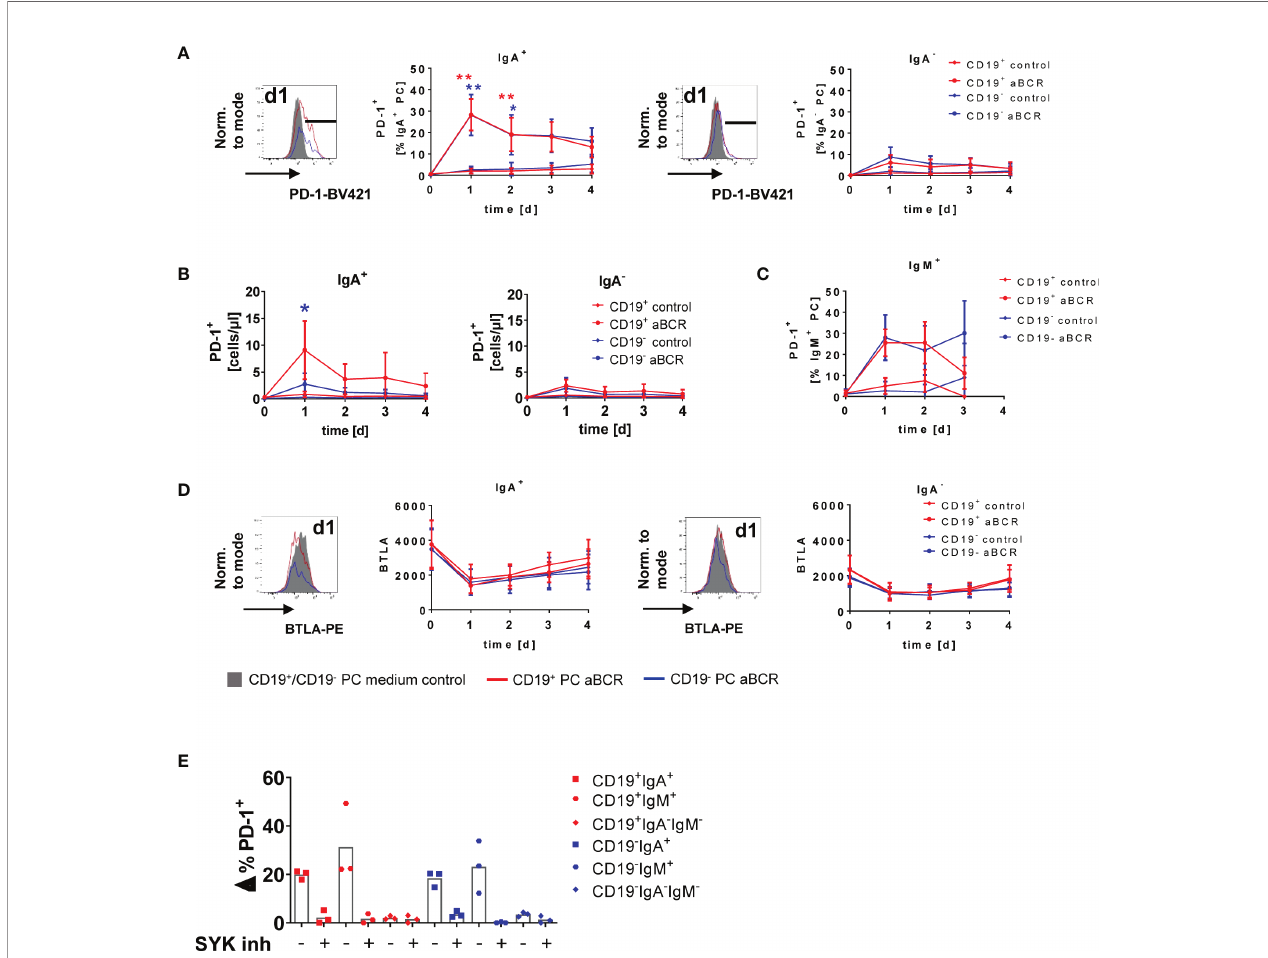
FIGURE 5 | PD-1 is upregulated on IgA-expressing BMPC following BCR stimulation. BM MNCs were cultured for up to four days in the presence of 1 µg/ml anti- BCR F(ab) 2 IgM/IgG/IgA (aBCR) or medium (control). (A) A representative histogram of PD-1 is shown ( fi lled grey: staining d1 medium control; solid lines: staining d1 aBCR). PD-1 expression on IgA + (left) and IgA − (right) BMPC was analyzed among the subsets de fi ned by CD19. Mean ± SD; n = 6 – 16 for each timepoint, Kruskal- Wallis-Test with Dunn ’ s correction for multiple comparisons. *p < 0.001, **p < 0.0001. (B) Absolute cell counts of PD-1 + cells during the culture with anti-BCR among IgA + (left) and IgA − (right) BMPC of CD19 + and CD19 − BMPC. Mean ± SD; n = 5 – 12 for each timepoint, Kruskal-Wallis-Test with Dunn ’ s correction for multiple comparisons. *p < 0.001. (C) PD-1 expression on IgM + BMPC was analyzed among the subsets de fi ned by CD19. Mean ± SD; n = 4 – 9 for each timepoint, Kruskal-Wallis-Test with Dunn ’ s correction for multiple comparisons. (D) Representative histogram (d1 medium control and aBCR) of BTLA (MFI) and cumulative data of IgA + and IgA − CD19 +/ − BMPC after BCR stimulation. n = 2 – 16 for each timepoint. (E) BM MNCs were incubated with SYK inhibitor entospletinib or DMSO as a control 30 min prior to stimulation with anti-BCR for 1 day and stained for PD-1 together with CD19, IgA and IgM. Frequency of PD-1 + cells from stimulated samples minus unstimulated controls ( D %) for the BMPC subsets de fi ned by CD19, IgA and IgM, bar indicates mean, n =